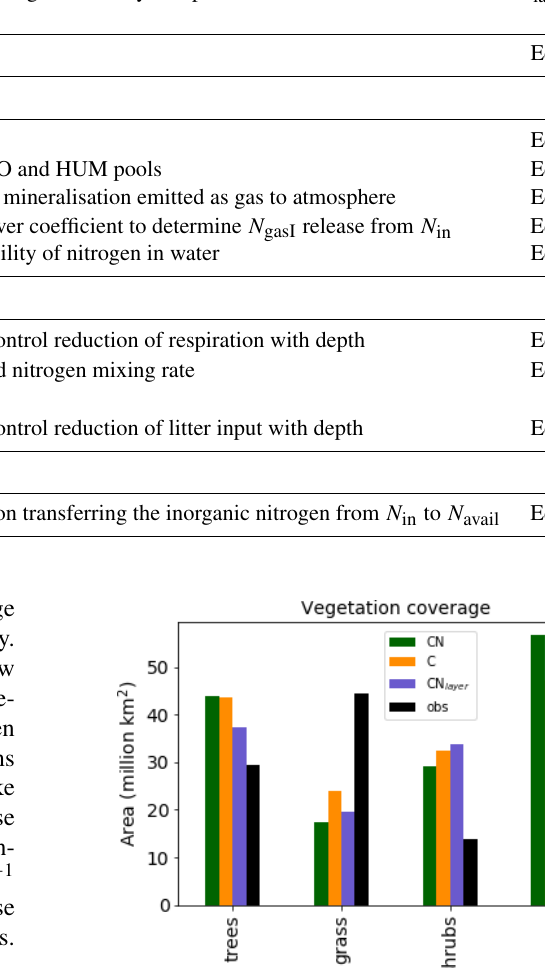
Table 2. A summary of the extra parameters required for the soil biogeochemistry component of JULES-CN and JULES-CN layer .